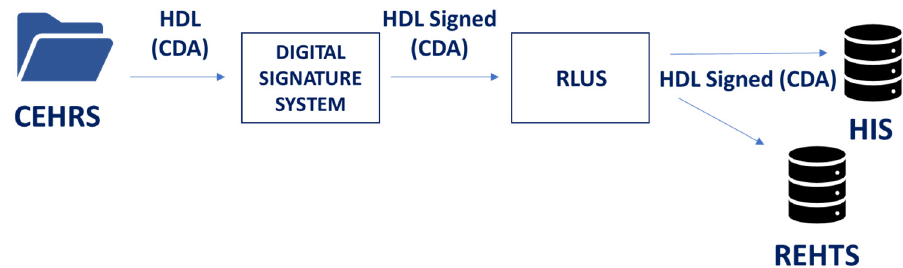
Figure 10. Pathway for the delivery of the